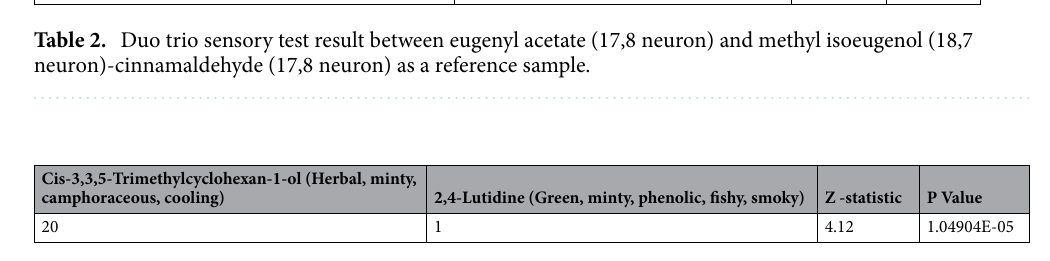
Table 3. Duo trio sensory test result between cis-3,3,5-Trimethylcyclohexan-1-ol (18,9 neuron) and methyl isoeugenol (17,9 neuron)- menthol (29,19 neuron) as a reference sample.